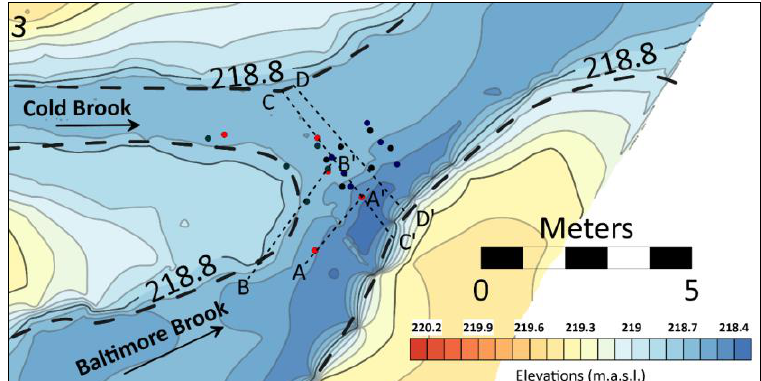
Figure 14. Test points and cross-sections in FS-BBCB1 and FS-BBCB2. Red, light blue, dark blue, and black points refer to September 2018, December 2018, October 2018, and March 2019, respectively.